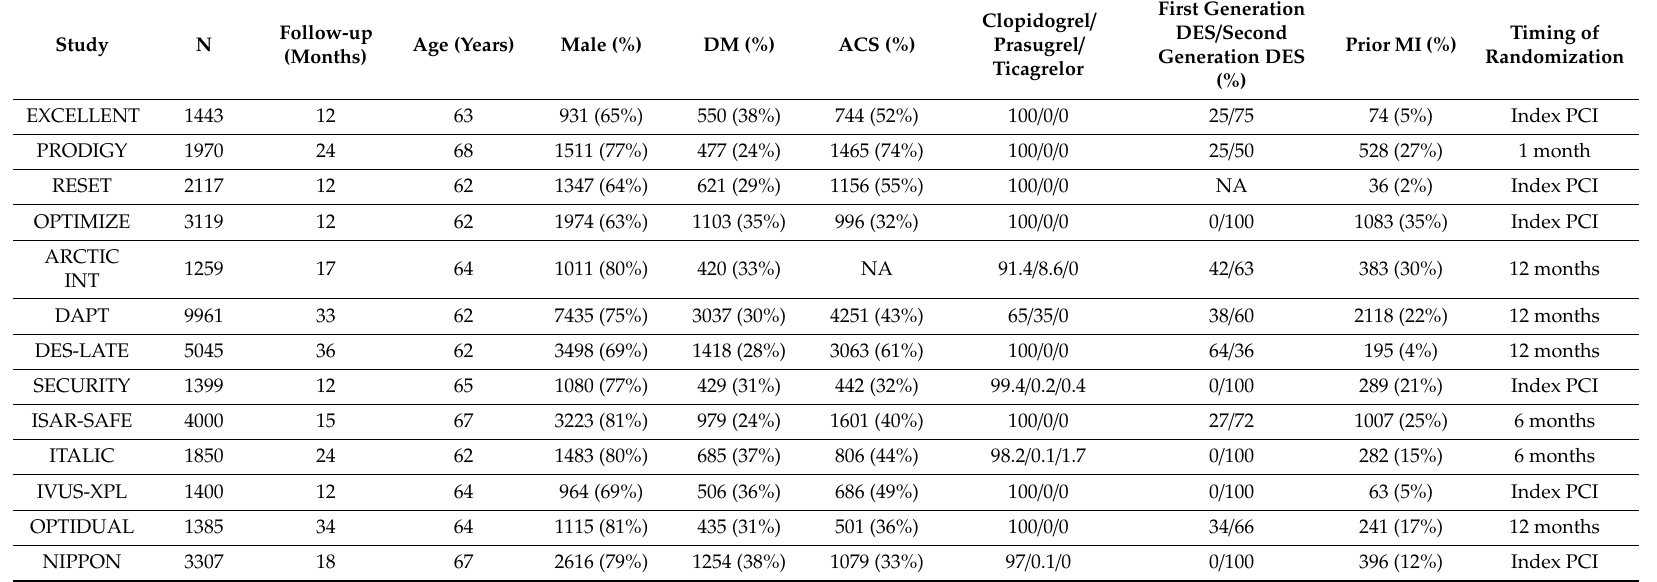
Table 2. Baseline patient characteristics in the including